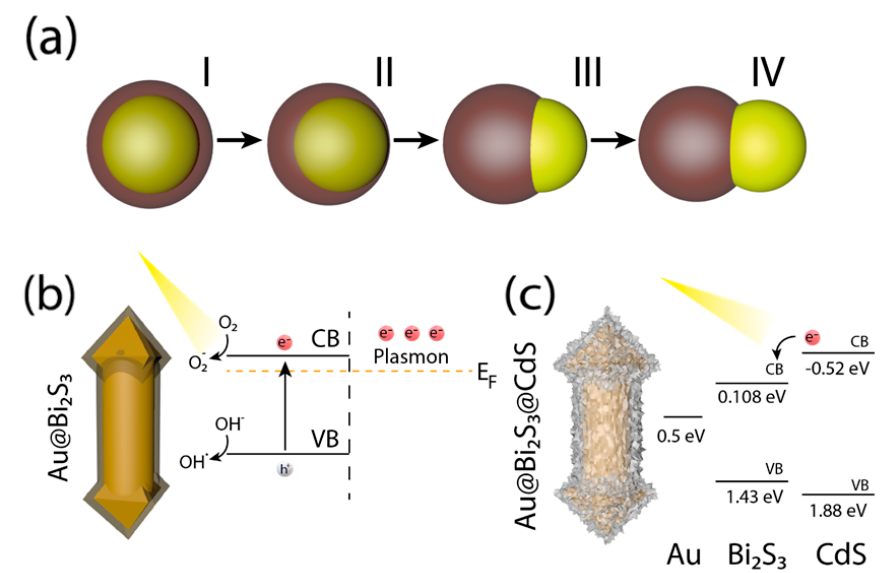
Figure 9. ( a ) Concentric core-shell (I), eccentric core-shell (II), and Janus (III, IV) hybrid structures (adapted from [137]); ( b ) AuNR@Bi 2 S 3 hybrid structure and its excitation mechanism under visible light irradiation; ( c ) AuNR@Bi 2 S 3 @CdS core-(double) shell hybrid structure. Excitation mechanism for